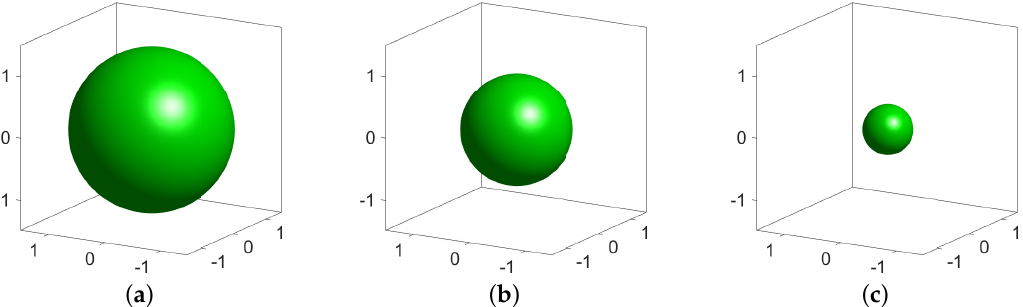
Figure 24. ( a ) Initial condition (77) . ( b , c ) are the snapshots of zero level set to the numerical solutions of the AC equation using the Fourier-spectral method after 480 and 800 iterations with ∆ t = 0.001,